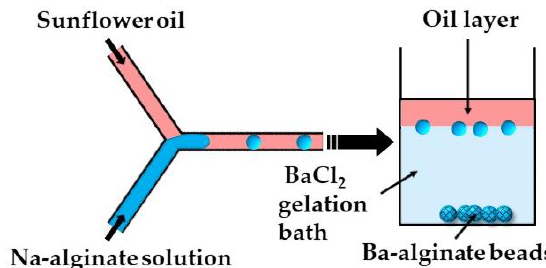
Figure 6. Formation of Ba-alginate beads by external gelation in a gelation bath. The continuous phase (sunflower oil) forms a top layer in the gelation bath, while alginate droplets move under gravity to a 1.5 wt% BaCl 2 solution, where Ba 2+ ions diffuse into droplets and cause their gelation [27].